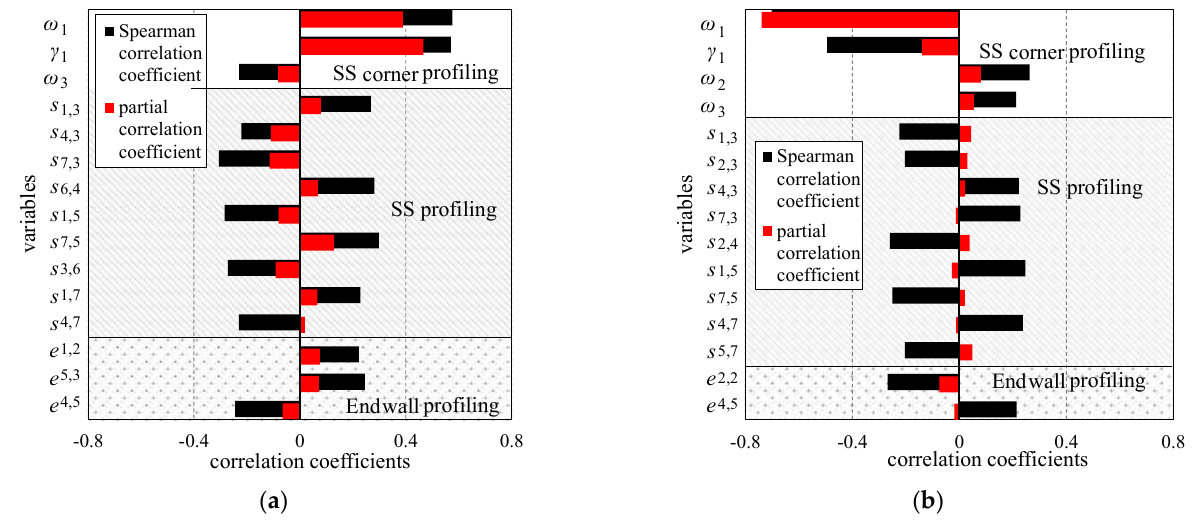
Figure 10. Correlation analysis between profiling parameters and ω o . ( a ) i = − 1 ◦ ; ( b ) i = 7 ◦ . Table 1. The quantitative analysis of the partial profiling cases.